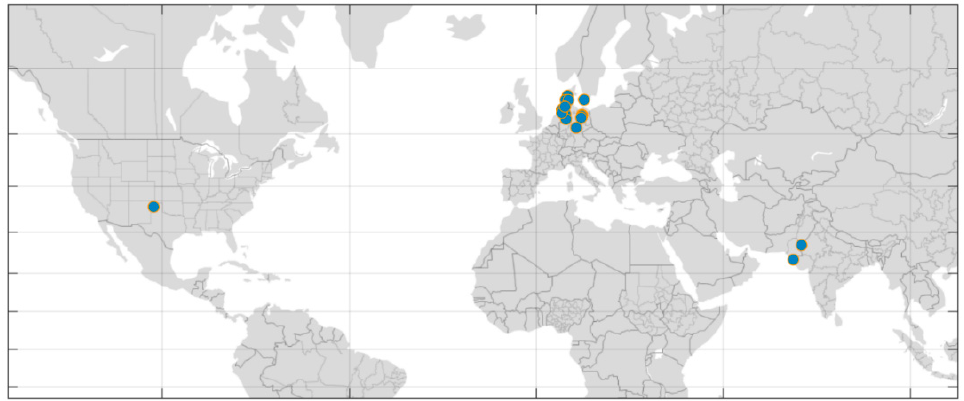
Figure 1. Locations of the 31 wind turbines on three different continents included in the climatic field-measurement campaigns evaluated in the present paper.